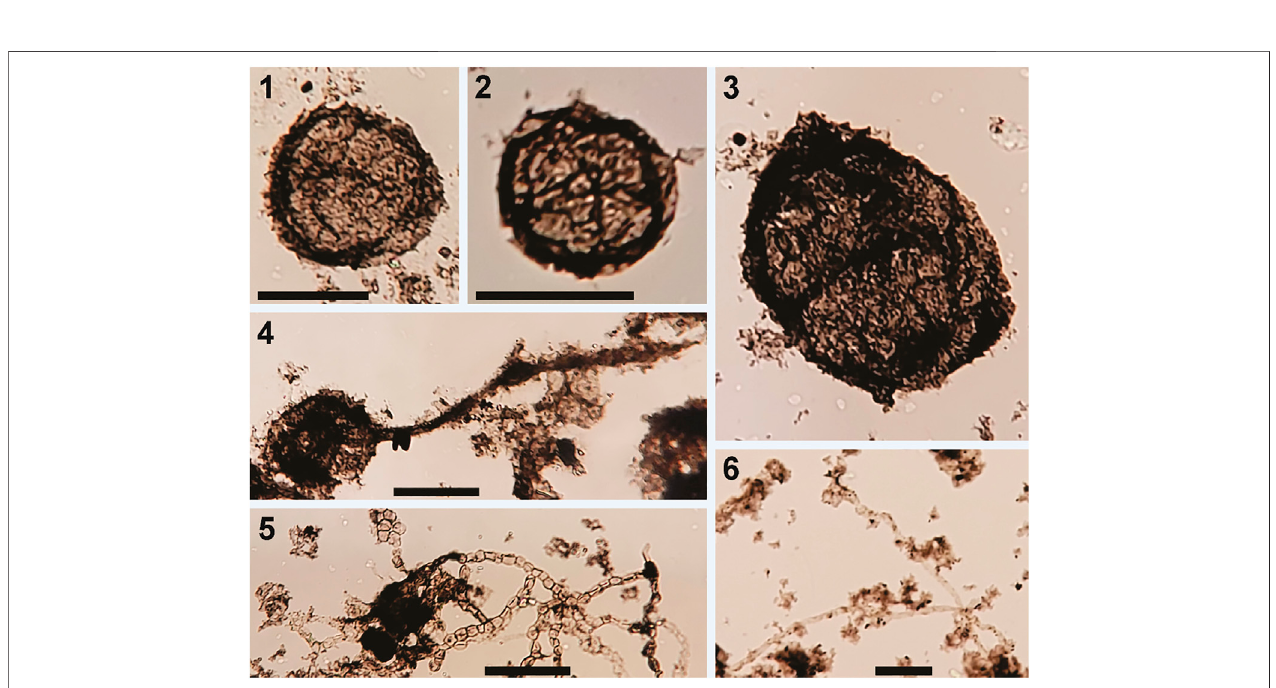
FIGURE 11 | Organic-walled microfossils recovered from Sete Lagoas Formation, Bambuí Group, Januária Municipality. (1 – 2) Leiosphaeridia minutissima (Naumova,1949) — CP963; (3) Leiosphaeridiatenuissima Eisenack,1958 — CP914; (4) Germinosphaerabispinosa Mikhailova,1986-CP917; (5) Ghoshia sp. — CP916; (6) Siphonophycus robustum (Schopf, 1968) — CP961. Scale bars: 25